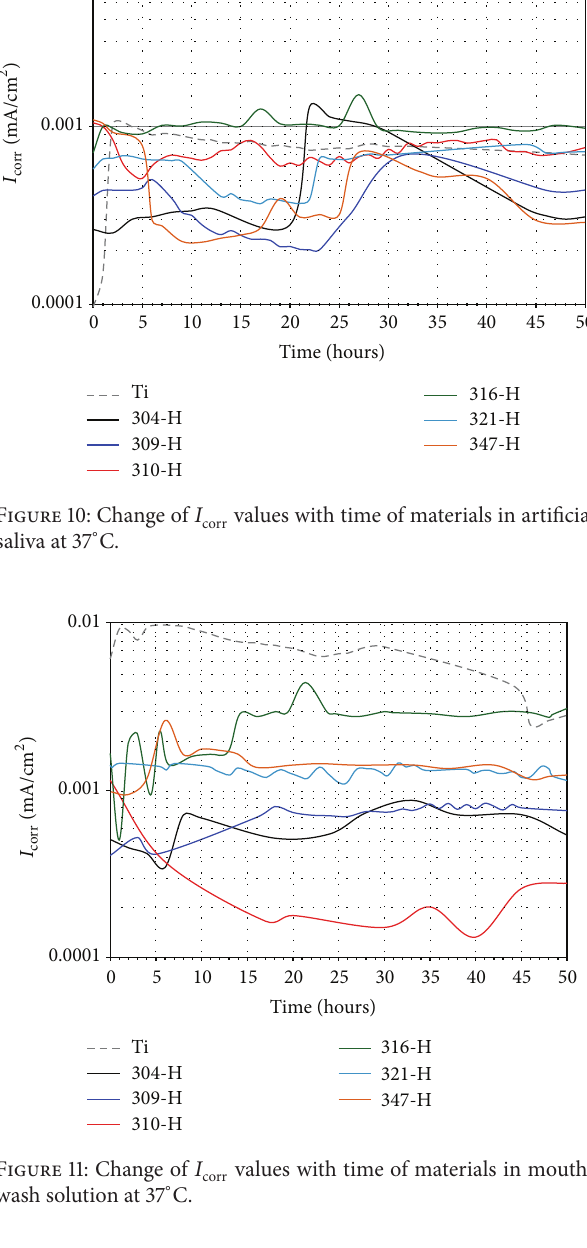
values with time of materials in mouth- corr